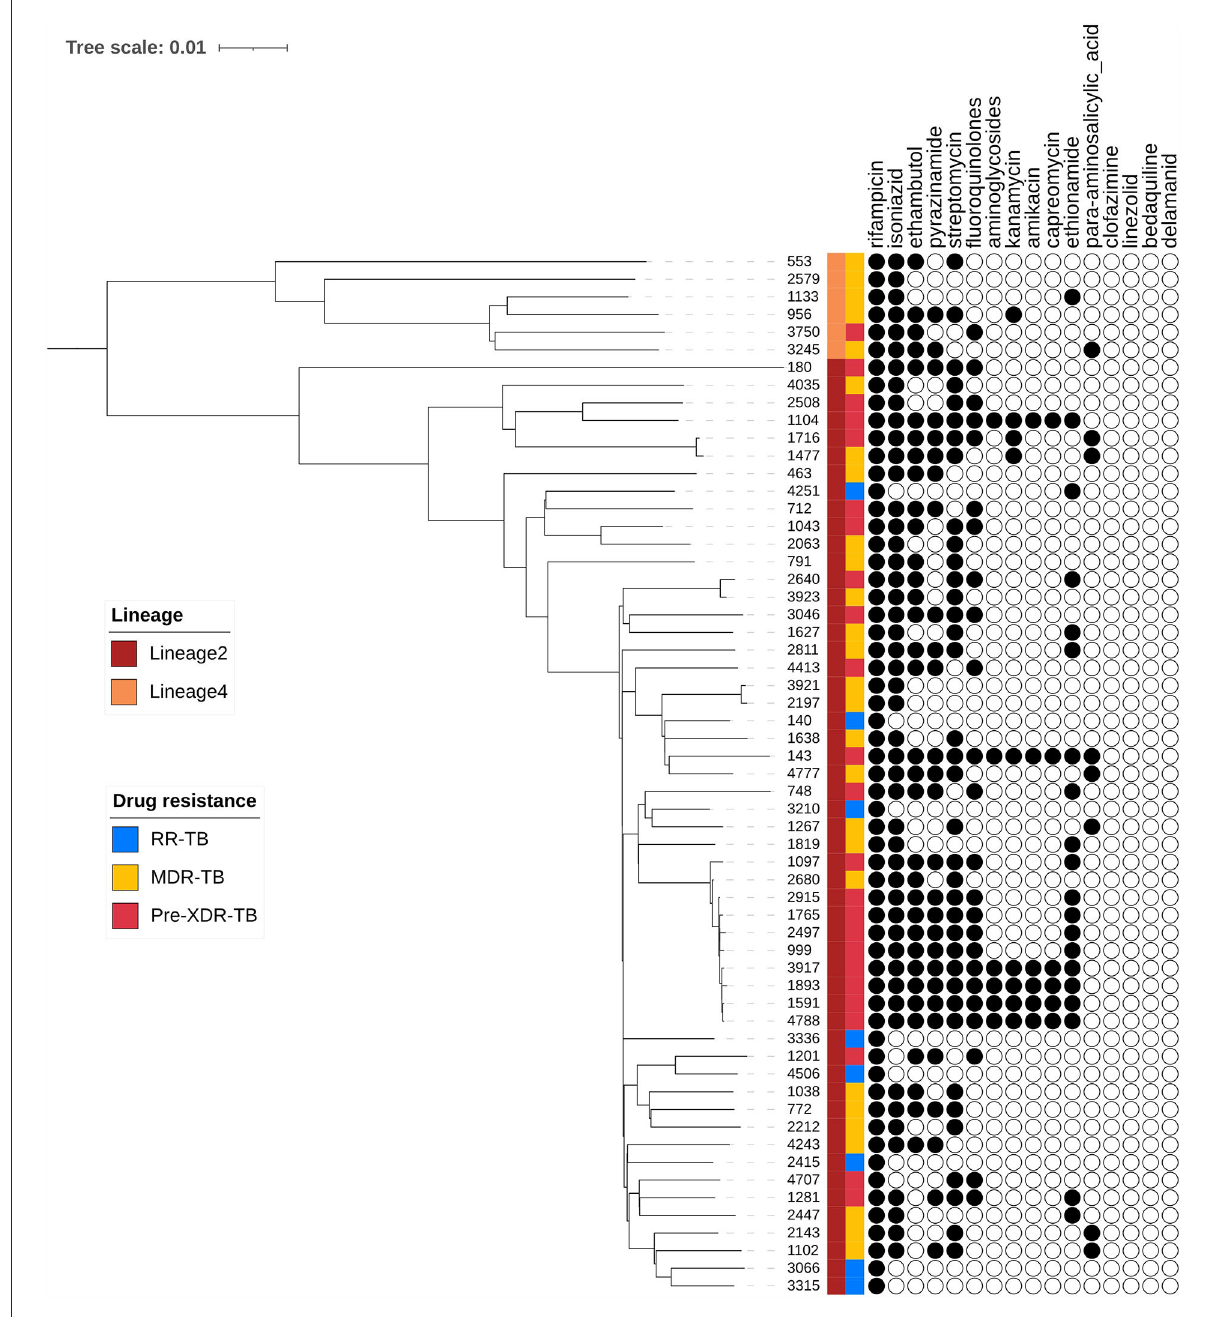
FIGURE1 Phylogenetic tree of 59 R-R MTB clinical samples showing drug resistance profiles and